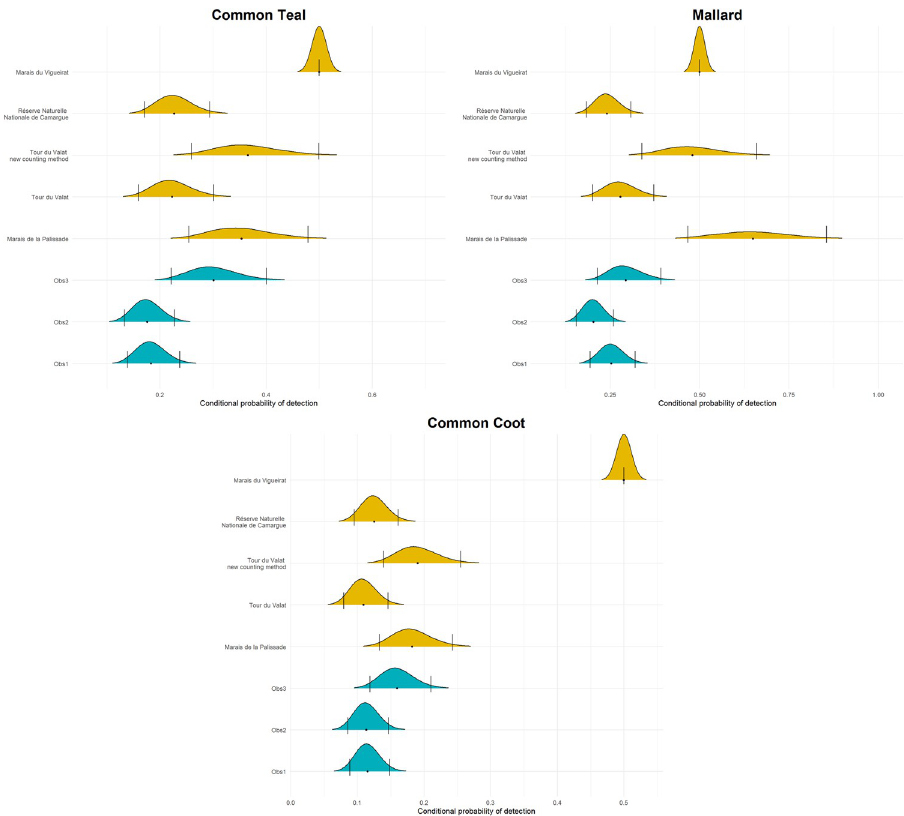
Fig 2. Density plot representing posterior distributions of the conditional detection probability for each of the observers (blue for aerial counts) and protected areas (yellow for ground counts). The dot represents the average of conditional probability of detection for each of these parameters and the dashed lines the associated 95% credible